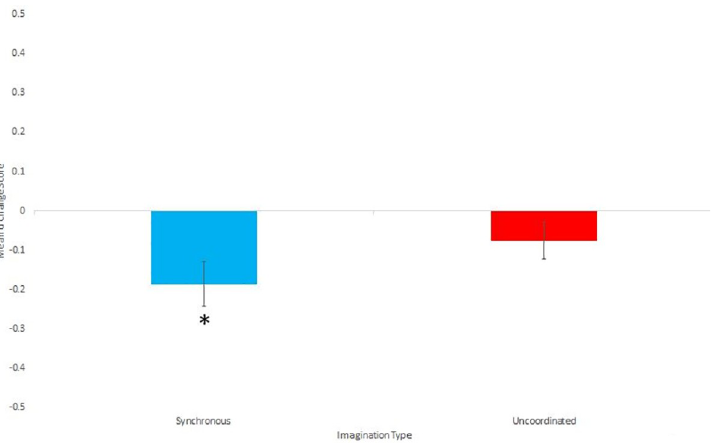
Fig 8. Means and standard errors for the d change scores for study